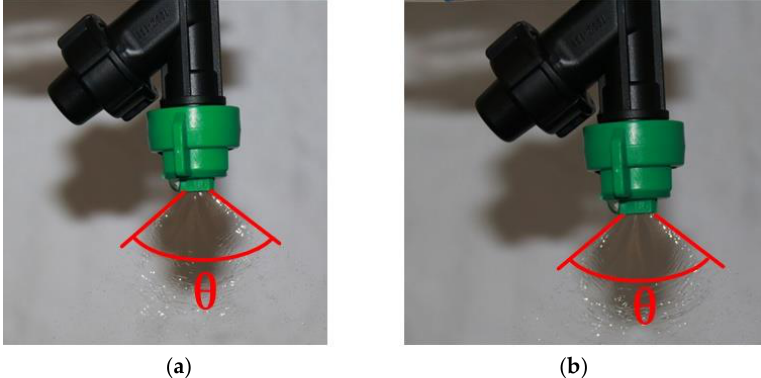
Figure 14. Spray angle of different PWM square wave duty ratios with a duty cycle of 40% ( a ) and a duty cycle of 100% ( b ). Note: θ is the spray angle.